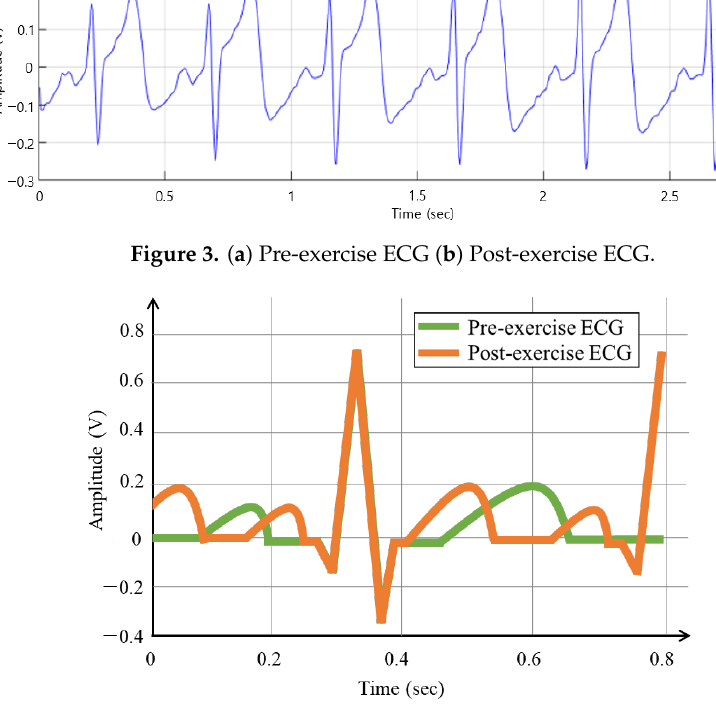
Figure 4. ECG segmented signals based on the R wave peak in pre- and post-exercise cases.